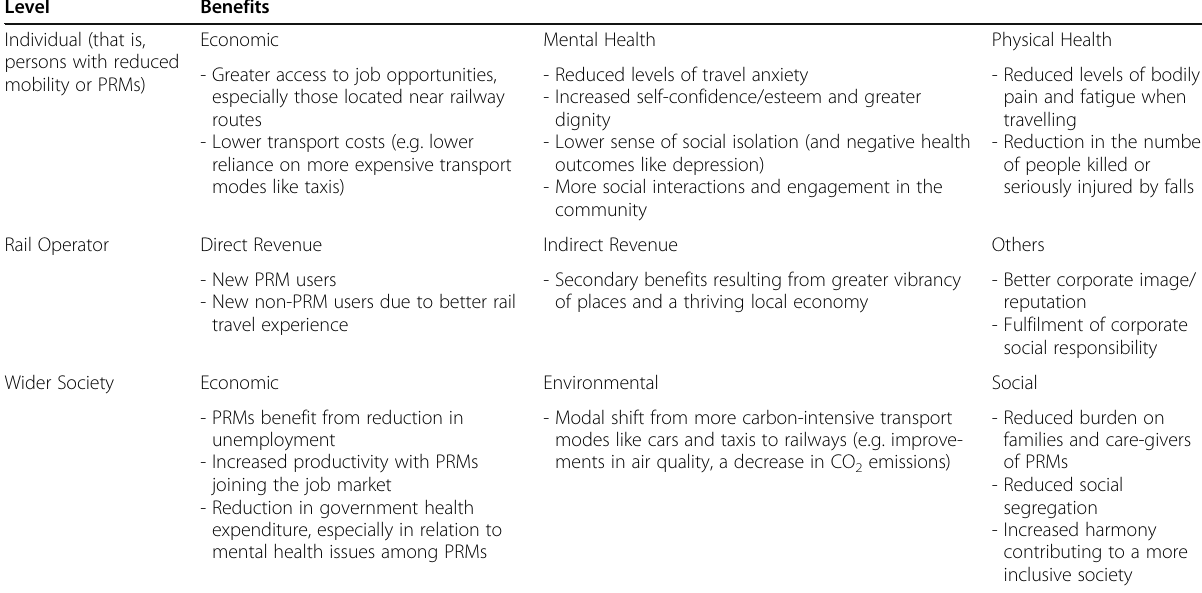
Table 2 Key benefits of inclusive railway design Level Benefits Individual (that is, persons with reduced mobility or PRMs)